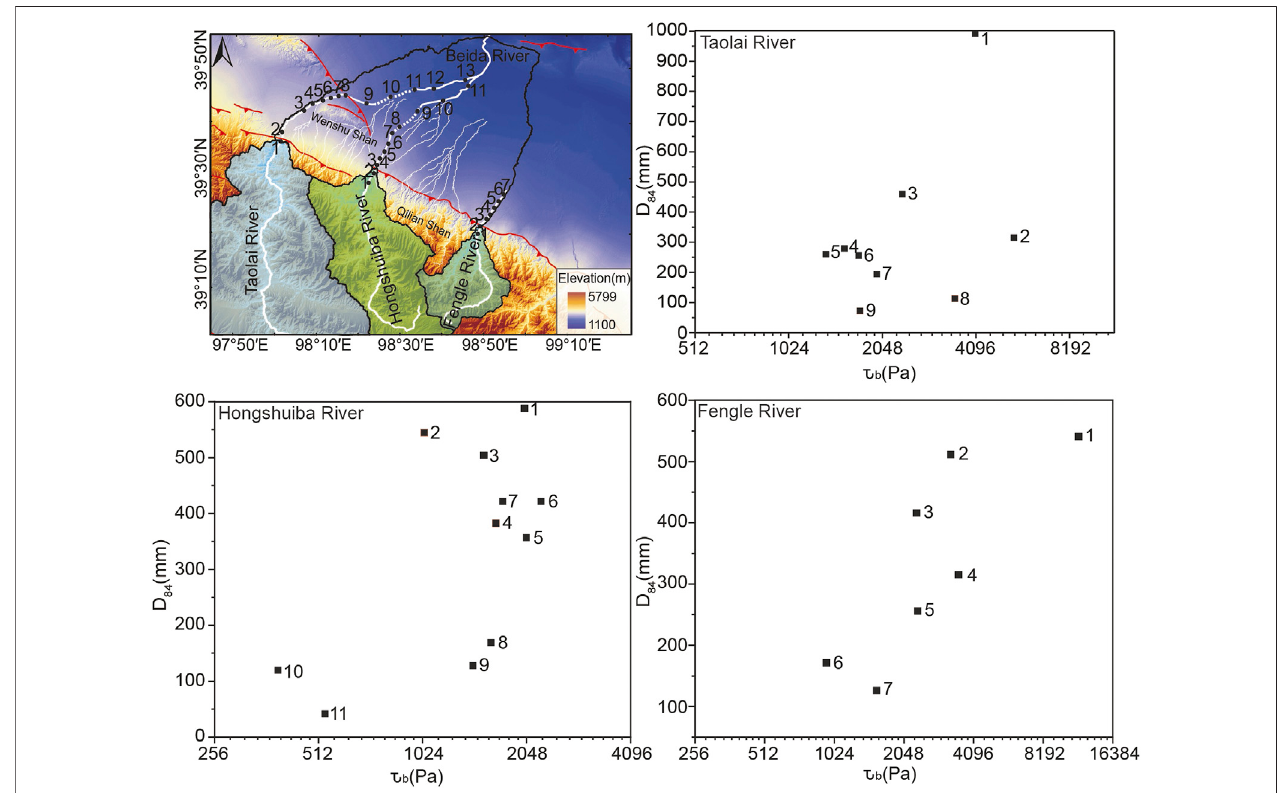
FIGURE 7 | Positive correlation checks between D 84 and τ b along the Taolai, Hongshuiba, and Fengle Rivers.